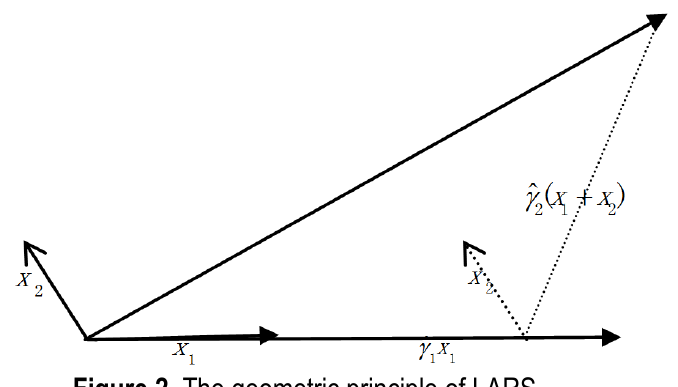
Figure 2. The geometric principle of